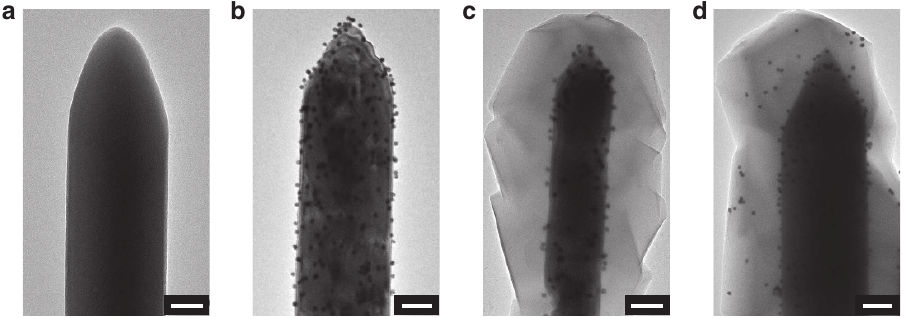
Figure 2 | The encapsulation of Au NPs into ZIF-8 with spatial regulation. TEM images of ( a ) ZnO NRs, ( b ) ZnO NRs@Au and ( c , d ) ZnO NRs@Au@ ZIF-8 composites with Au NPs at different locations: ( c ) inside and ( d ) near to the surface of ZIF-8. Scale bar, 100nm.